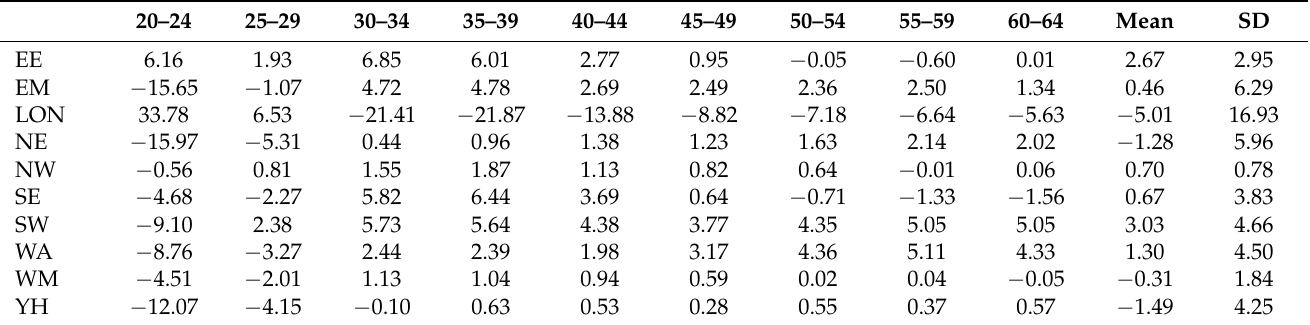
Table 1. Net Migration Rates by working age-band: Regions. The table reports regional net migration rates for English and Welsh regions over nine 5-year age bands. Mean = Mean net migration rate, SD = Standard